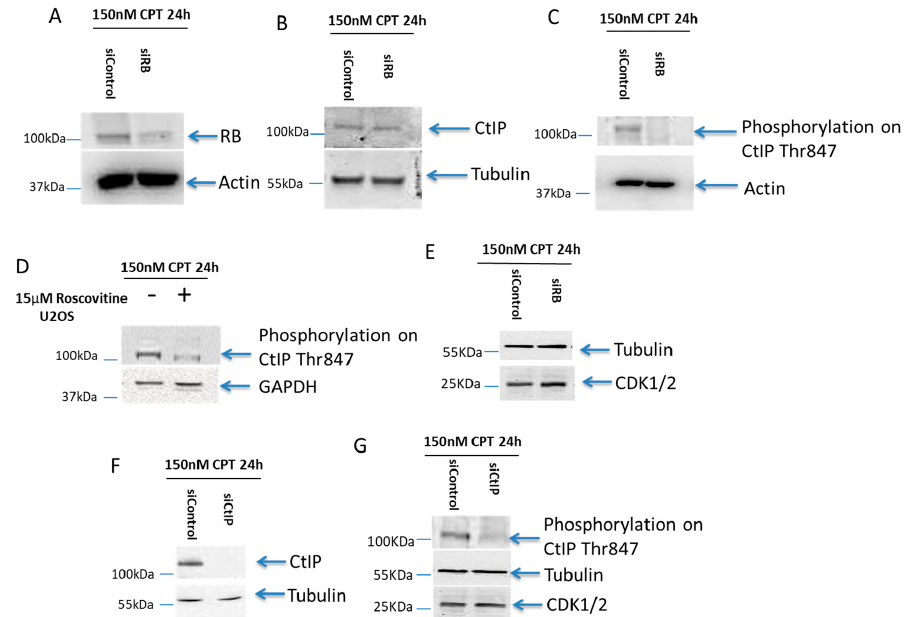
Figure 3. RB regulated CDK2-mediated CtIP phosphorylation on Thr847. ( A ): RB was knocked down